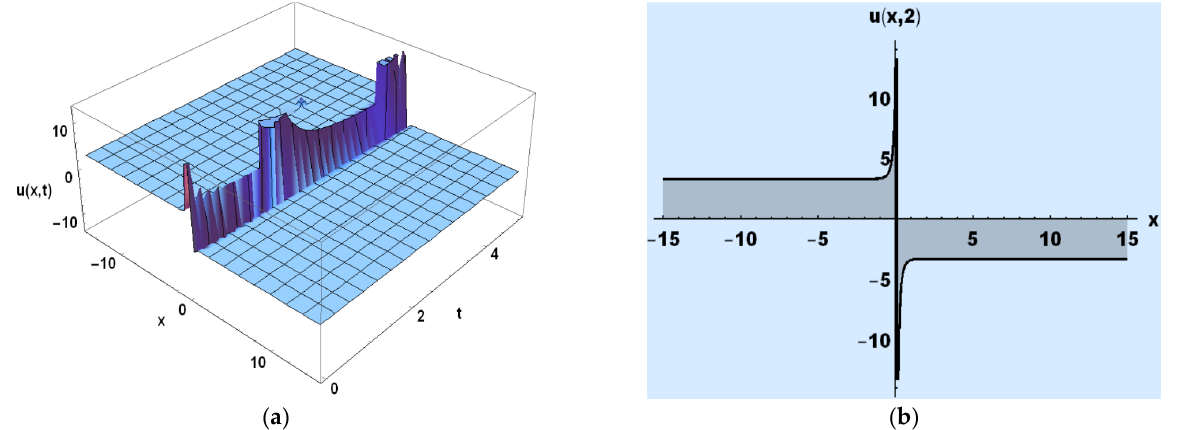
Figure 2. ( a , b ): Graphical analysis of Equation (23) for the values of the parameters A = 2, B = − 3, E = 1, F = 1, H = 1, ψ = 1, δ = − 2, L = 1, α = 0.75, − 15 ≤ x ≤ 15, 0 ≤ t ≤ 5 for 3D and t = 2 for 2D plots.